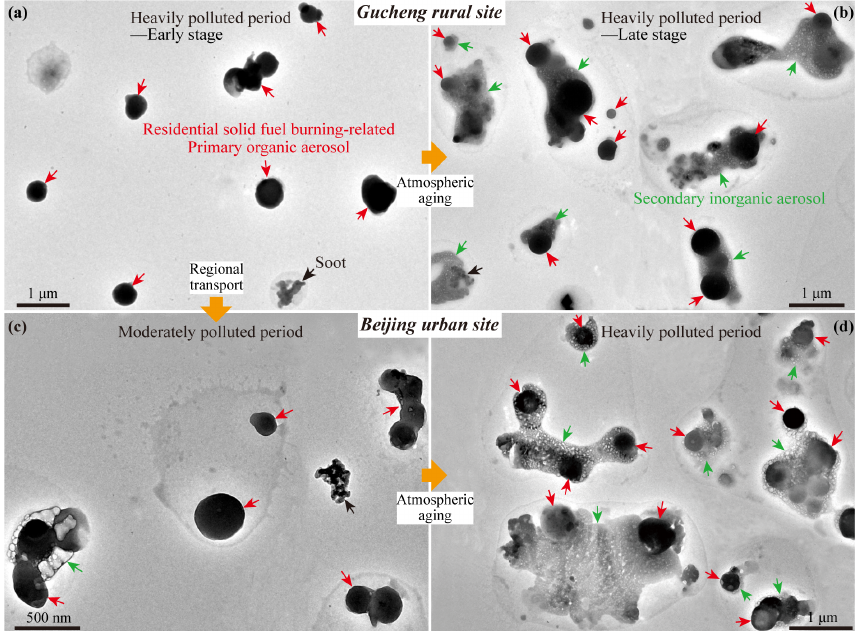
Figure 6. TEM images showing individual particles collected in the (a) early stage and (b) late stage of the heavily polluted period at the Gucheng rural site and in the (c) moderately polluted and (d) heavily polluted periods at the Beijing urban site. The red, green, and black arrows indicate primary organic aerosol (POA) particles, secondary inorganic aerosol (SIA) particles, and soot particles, respectively.